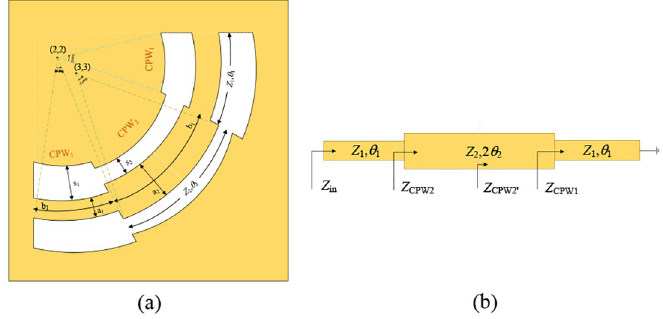
Fig 4. CPW equivalent analysis. (a) arc-shaped coplanar waveguide. (b) traditional